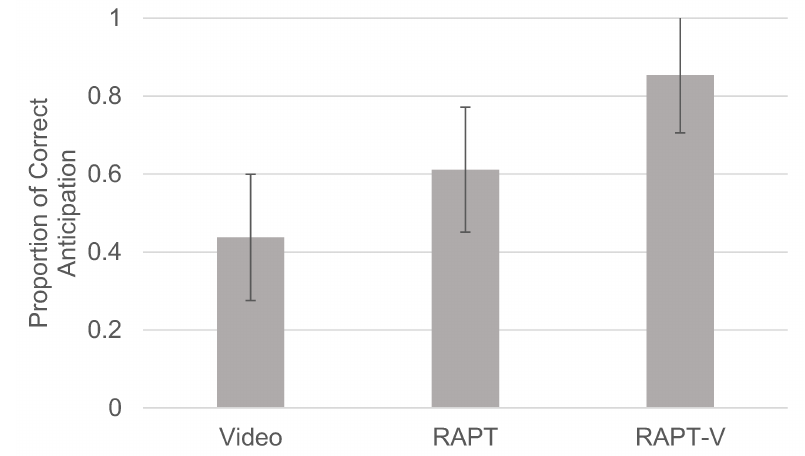
Figure 1. Mean proportion of correct anticipation performance across the training conditions (Video, RAPT and RAPT-V conditions). Error bars represent between-participant 95% confidence